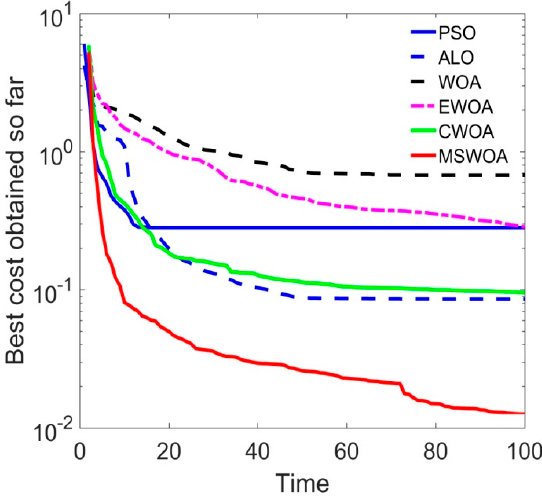
Figure 8. Comparison of average iteration process under no-load condition.